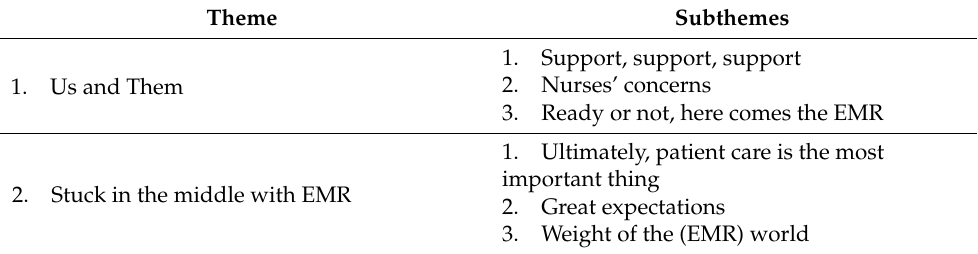
Table 4. Themes and